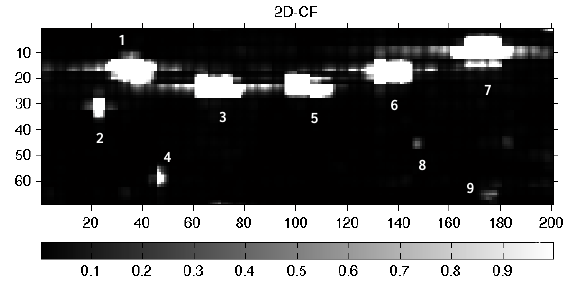
Figure 7. The span image after convolution. 1-9 mark the targets with higher power than ocean